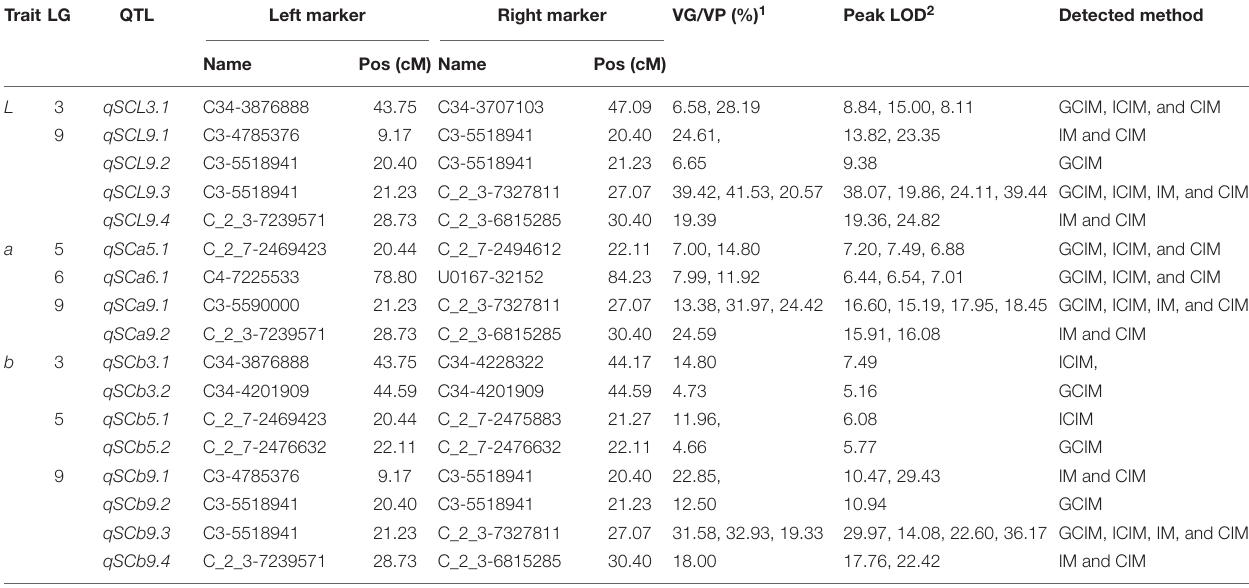
TABLE 2 | QTL distribution of the seed coat color using L , a , and b values in sesame. Trait LG